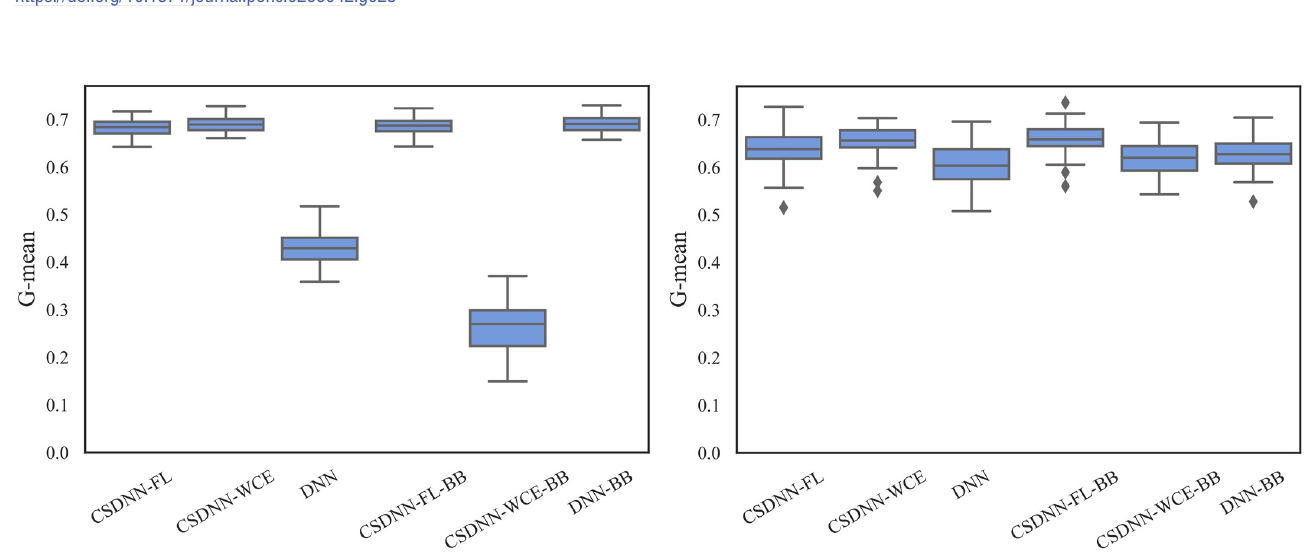
Fig 23. Comparison of CSDNN-FL and CSDNN-WCE versus DNN (in terms of G-mean) on the Native American Texas and Oklahoma datasets. Each boxplot denotes variability of the G-mean (vertical axis) for different methods.